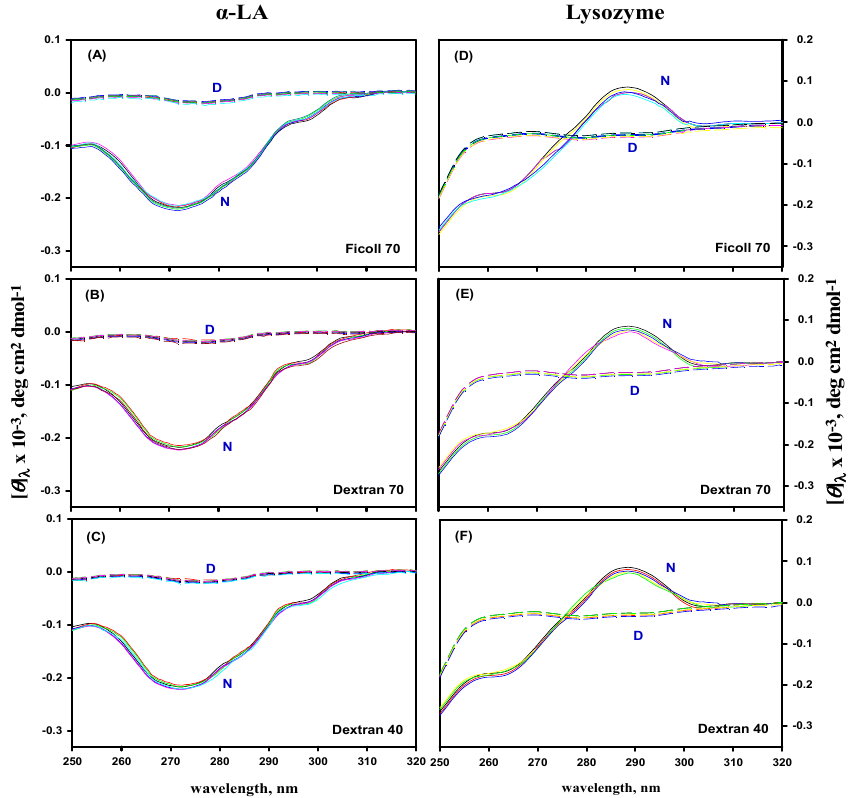
Figure 6. The near-UV CD spectra of the native and denatured states of α -LA (panels A – C ) and lysozyme (panels D – F ) in the absence and presence of di ff erent concentrations of ficoll 70, dextran 70, and dextran 40 at pH 7.0. N and D in each panel represent the native and denatured states of both the proteins,